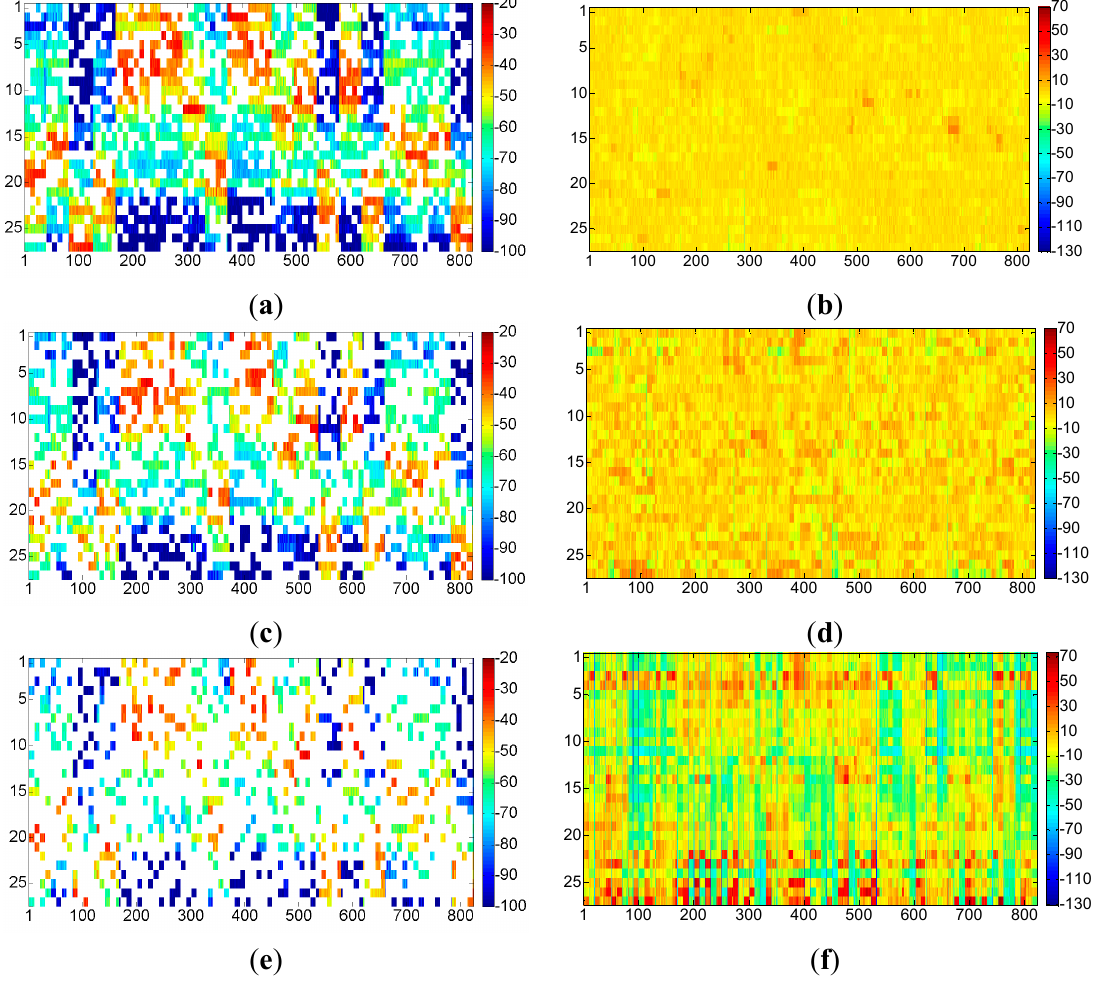
Figure 14. Radio map recovery error in different cases of access points powered off. ( a ) Sensed radio map (10 access points off); ( b ) Recovery Error (10 access points off); ( c ) Sensed radio map (15 access points off); ( d ) Recovery Error (15 access points off); ( e ) Sensed radio map (20 access points off); ( f ) Recovery Error (20 access points